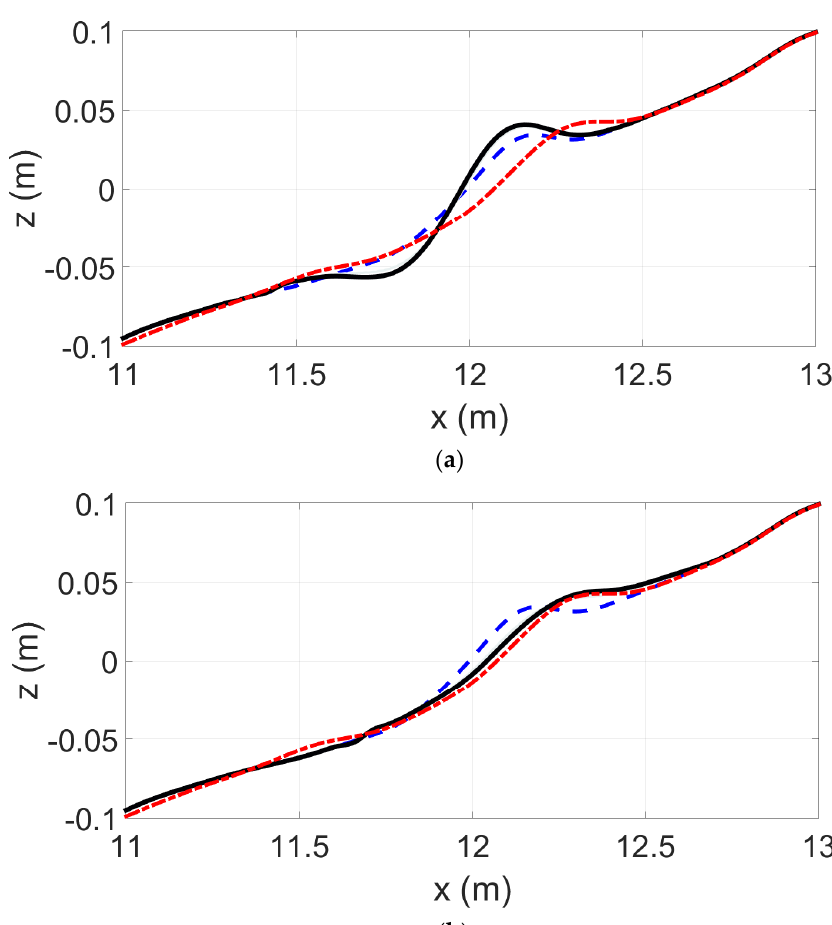
Figure 12. ( a ). Local sediment transport as presented in Figure 11a, centred and normalized ac- cording to the peak in transport, together with the mean transport pattern (dashed magenta line). ( b ) Cumulative net bulk sediment transport, Q, versus time for data (dots) and equilibrium model. For modelling purposes, the transport Q is first fitted to the exponential-based law Q eq (1 −